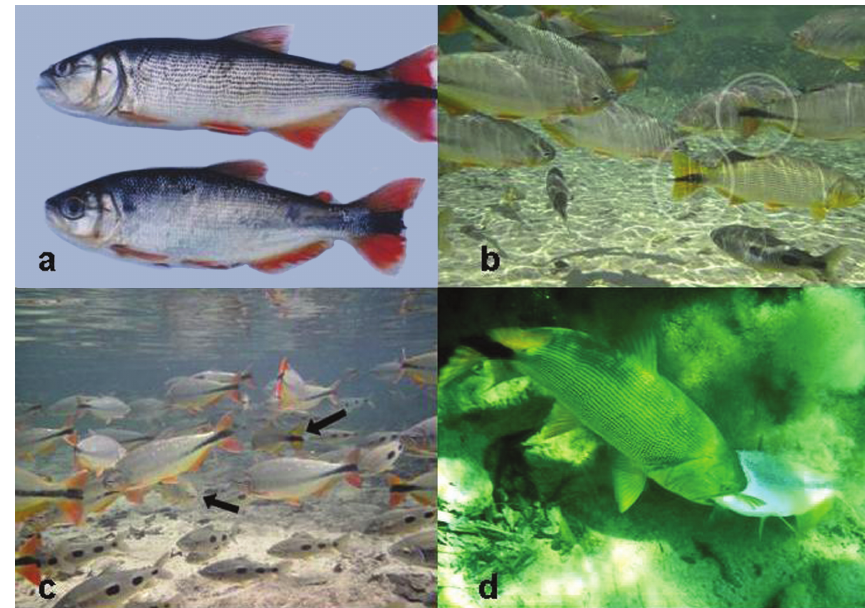
Fig. 1. Aggressive mimicry between the dourados Salminus brasiliensis and the piraputanga Brycon hilarii. Notice the resemblance in fins, general body colours and shape between the dourado (top) and the piraputanga (bottom) ( a ). Mixed school of about 30 cm total length piraputangas and dourados; the white circles point the similarity in caudal fin’s colour in live individuals of both species ( b ). Juvenile dourados (black arrows) mimicking the piraputangas in a mixed school, both fishes were about 30 cm TL ( c ). Adult dourado preying a piraputanga; mimicry is expected to end when dourados are 0.3 times bigger than the piraputangas that they eat ( d ). Photos: JS (a and d), LNC (b and